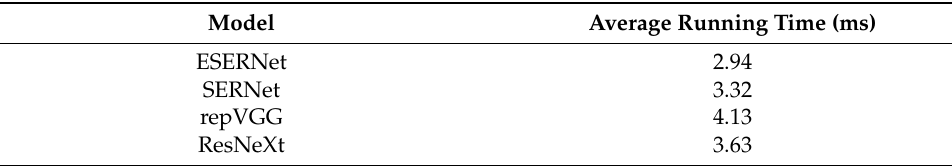
Table 3. Classification Accuracy of Blast Furnace Tuyere Images by Different